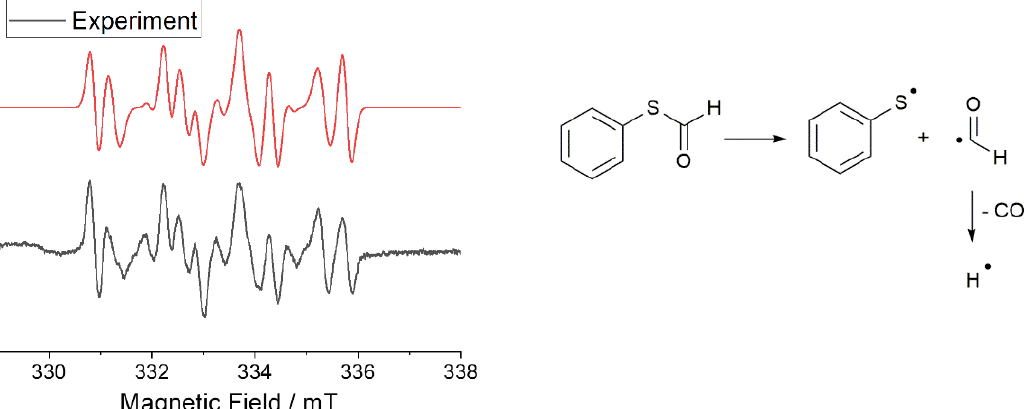
Figure 1. Conversion of S-phenyl thioformate under UV illumination (right, 254 nm, 5.08 mW cm −2 ).